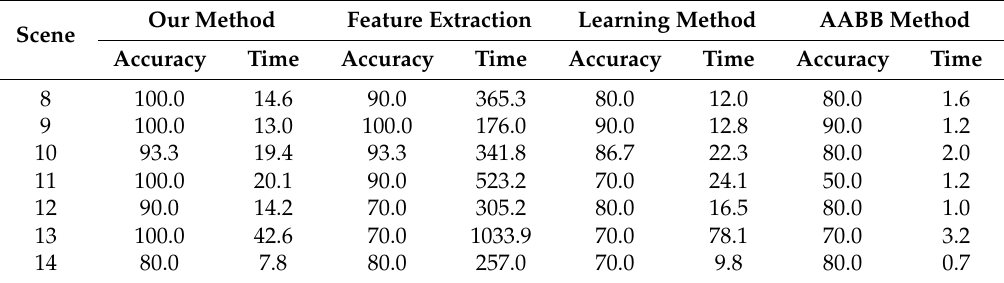
Table 4. Accuracy (%) and time (s) on the YCB